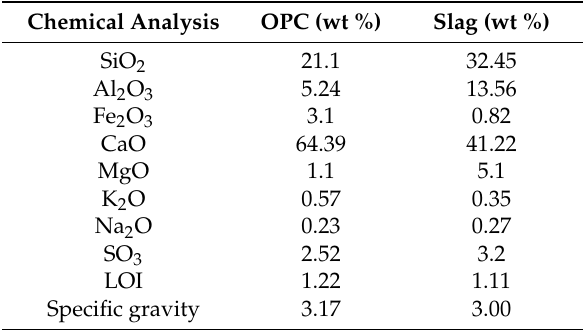
Figure 1. Analysis of construction and demolition wastes used as recycled coarse aggregates in this study. Table 2. Chemical and physical properties of Ordinary Portland cement (OPC) and